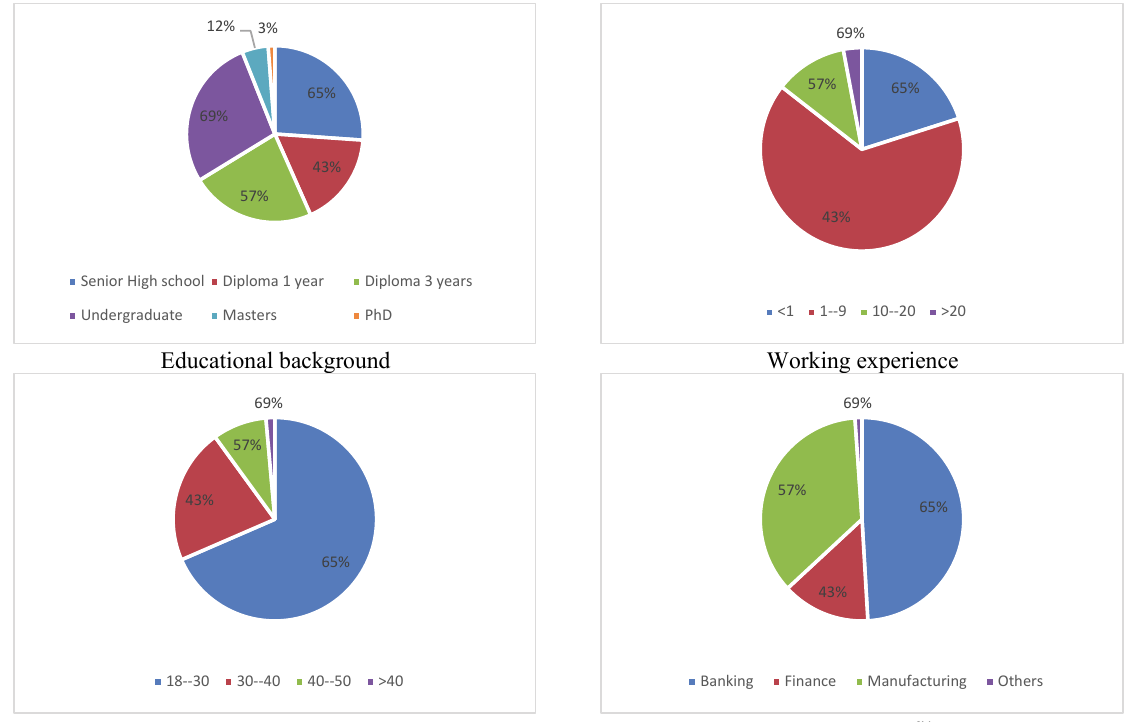
Fig. 2. Demographic data of the